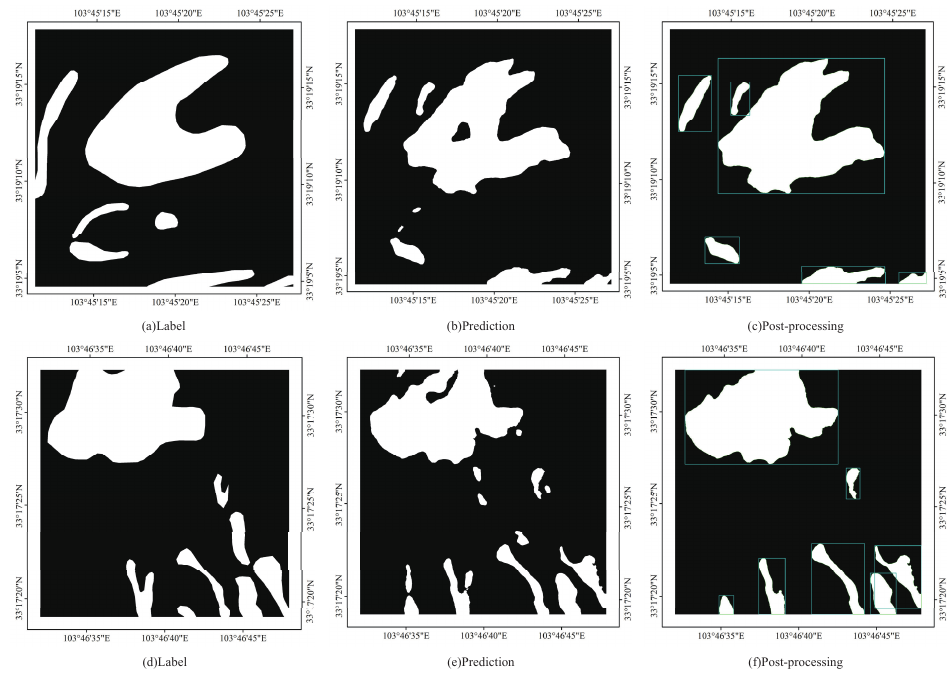
Figure 9. Visualization results of